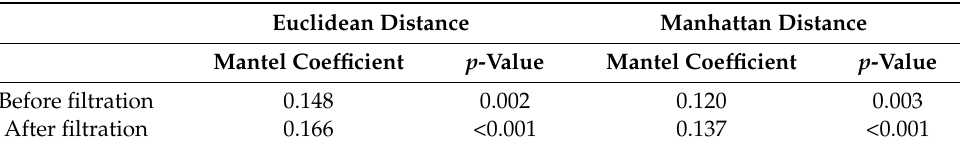
Table 3. Mantel test between core bacteria and